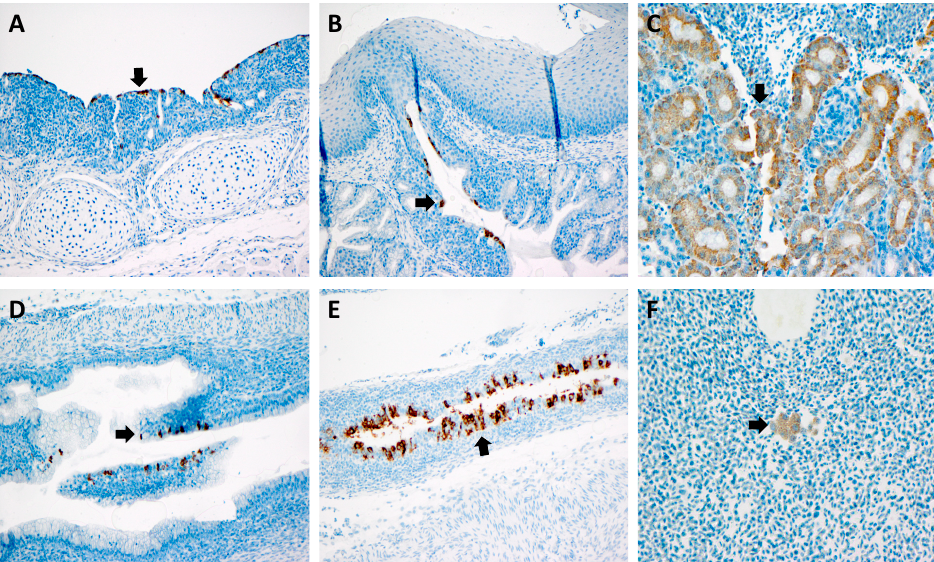
Figure 5. RNAScope findings: ( A ) IBV in the tracheal epithelium (arrow) of a 10-day-old bird challenged with DMV at 3 DOA; ( B ) IBV in the salivary gland epithelium (arrow) of a 10-day-old bird challenged with DMV at 3 DOA; ( C ) IBV in the renal tubular epithelium (arrow) of a 10-day-old bird challenged with DMV at 3 DOA; ( D ) IBV in the ureter epithelium of a 10-day-old bird challenged with DMV at 3 DOA; ( E ) IBV in the oviduct epithelium (arrow) of a 10-day-old bird challenged with DMV at 3 DOA; ( F ) IBV in blood monocytes (arrow) within the oviduct of a 2-week-old bird challenged with M41 at 3 DOA.